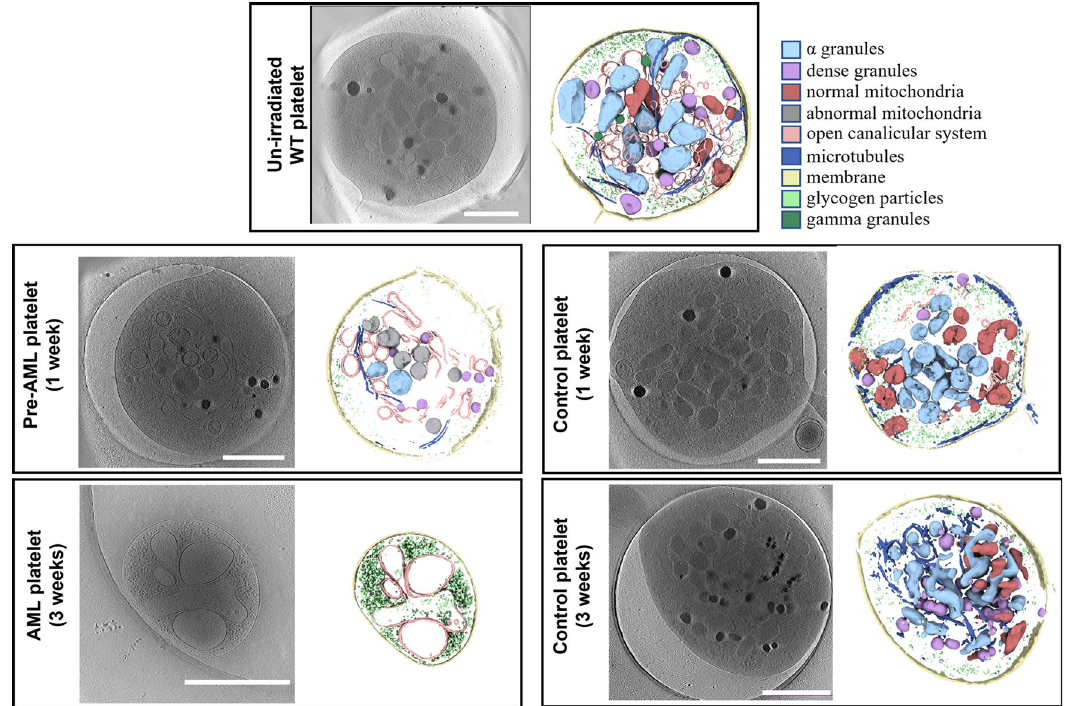
Fig. 1 Cryo-ET of platelets from mice in different states. Platelets from un-irradiated WT mice and BMT control mice had typical features including α granules, dense granules, gamma granules, mitochondria, intact membrane, microtubules, glycogen particles, and an open canalicular system (OCS). The platelets from AML mice (3 weeks) showed small round or oval shape without pseudopods. There were only glycogen particles and OCS inside. Platelets from pre-AML mice (1 week) can contain a mixture of normal and abnormal mitochondria. The example shown has only abnormal mitochondria. Color scheme used in segmentation is indicated in the panel. (Scale bar 1 µ